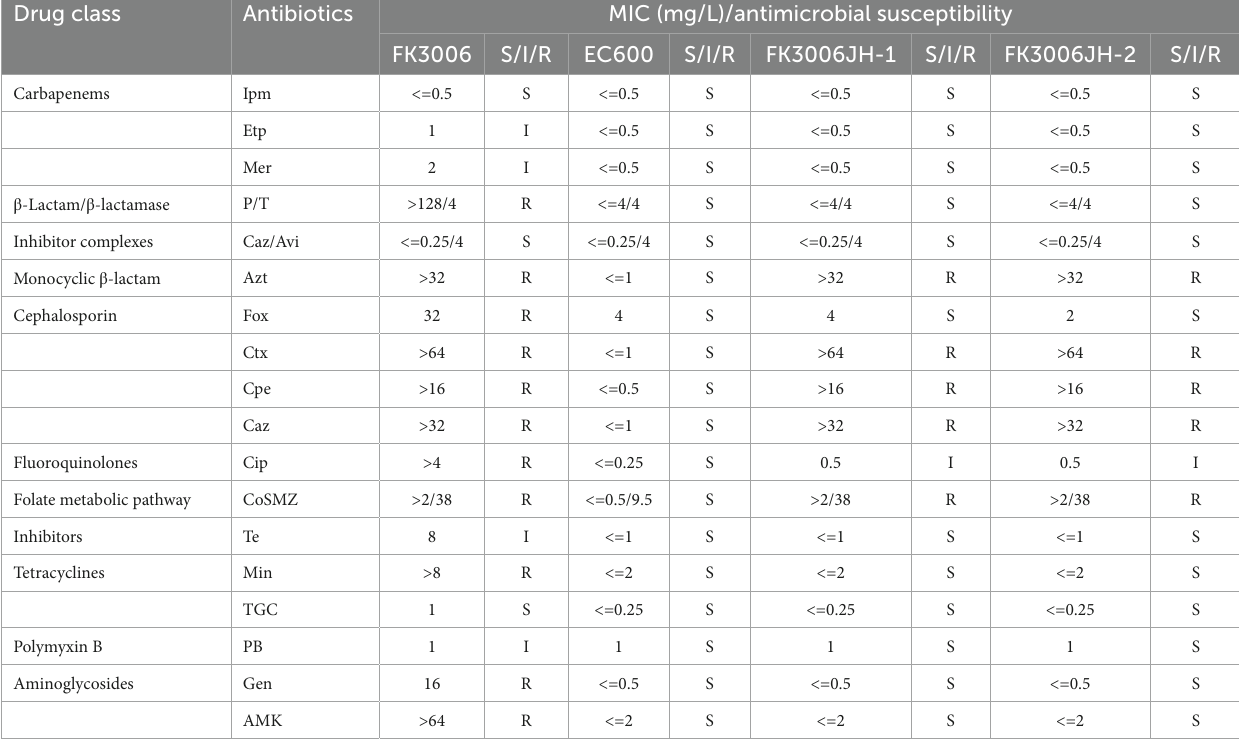
TABLE 1 Antimicrobial drug susceptibility